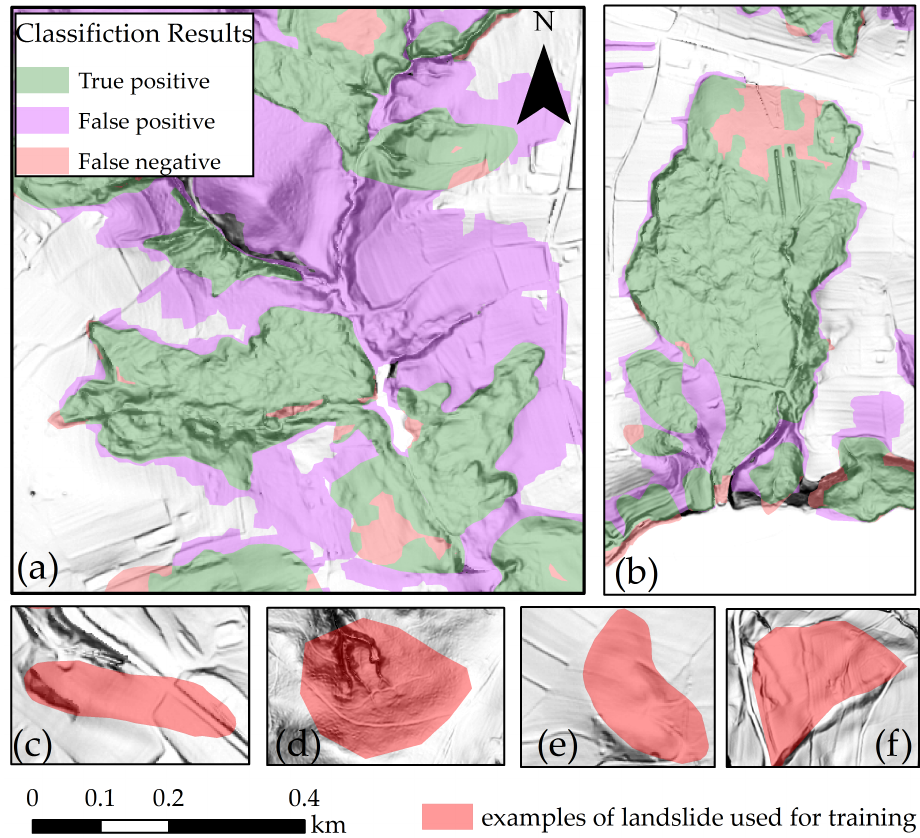
Figure 10. Landslide prediction in the testing area ( a ) with a large false positive rate, ( b ) with small false positive rate and ( c – f ) examples of landslides used for training the RF algorithm superimposed with the hillshade